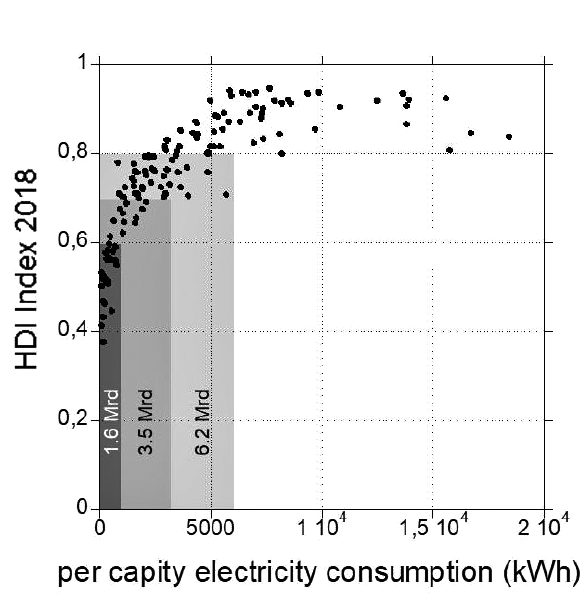
Fig. 1. – The Human Development Index, HDI, vs. the annual electricity consumption per capita . The shaded areas indicate the number of people with an HDI less than 0.6, 0.7, and 0.8, respectively. Data are taken from United Nations Human Development Reports, the 2014 electrical data are taken from the World Bank, the 2017 ones from the IEA atlas of energy. For comparison, the electrical data are linearly extrapolated to 2018. Data from Norway (0.954, 23 kWh) and Iceland (0.938, 54 kWh) are